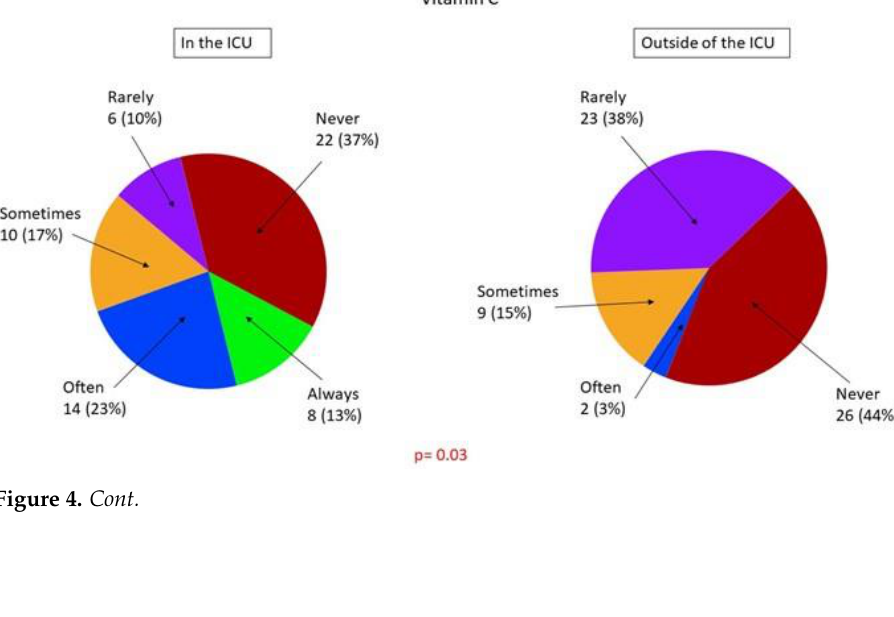
Figure 4. Application of the Vitamin C, Thiamine and Steroids in Sepsis (VICTAS) protocol in the ICU and outside the ICU environment.